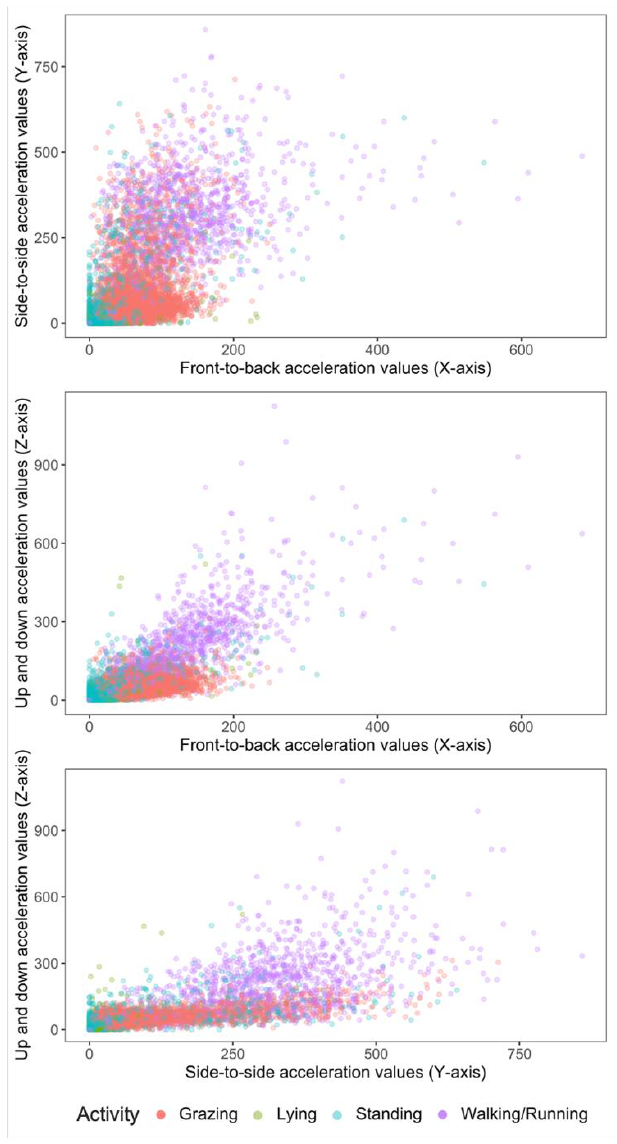
Figure 2. 2-D scatter plots of acceleration signals recorded in X, Y and Z axes of six ewe lambs during periods of grazing, standing, lying and walking. Table 3. Count of activity for four ewe lambs at five seconds interval over a one-hour period. Observations coded by one observer on two occasions (18 months